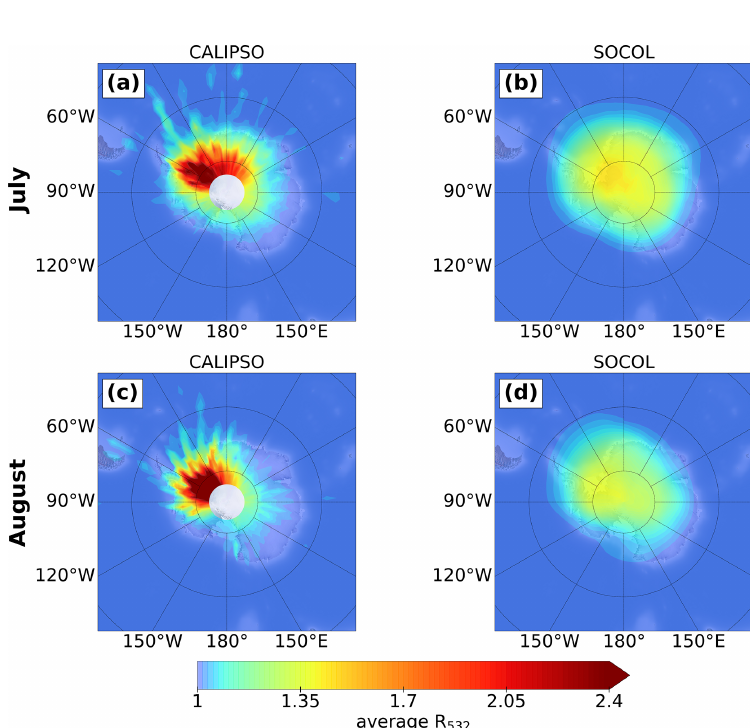
Figure A4. As Fig. 4, but for the year